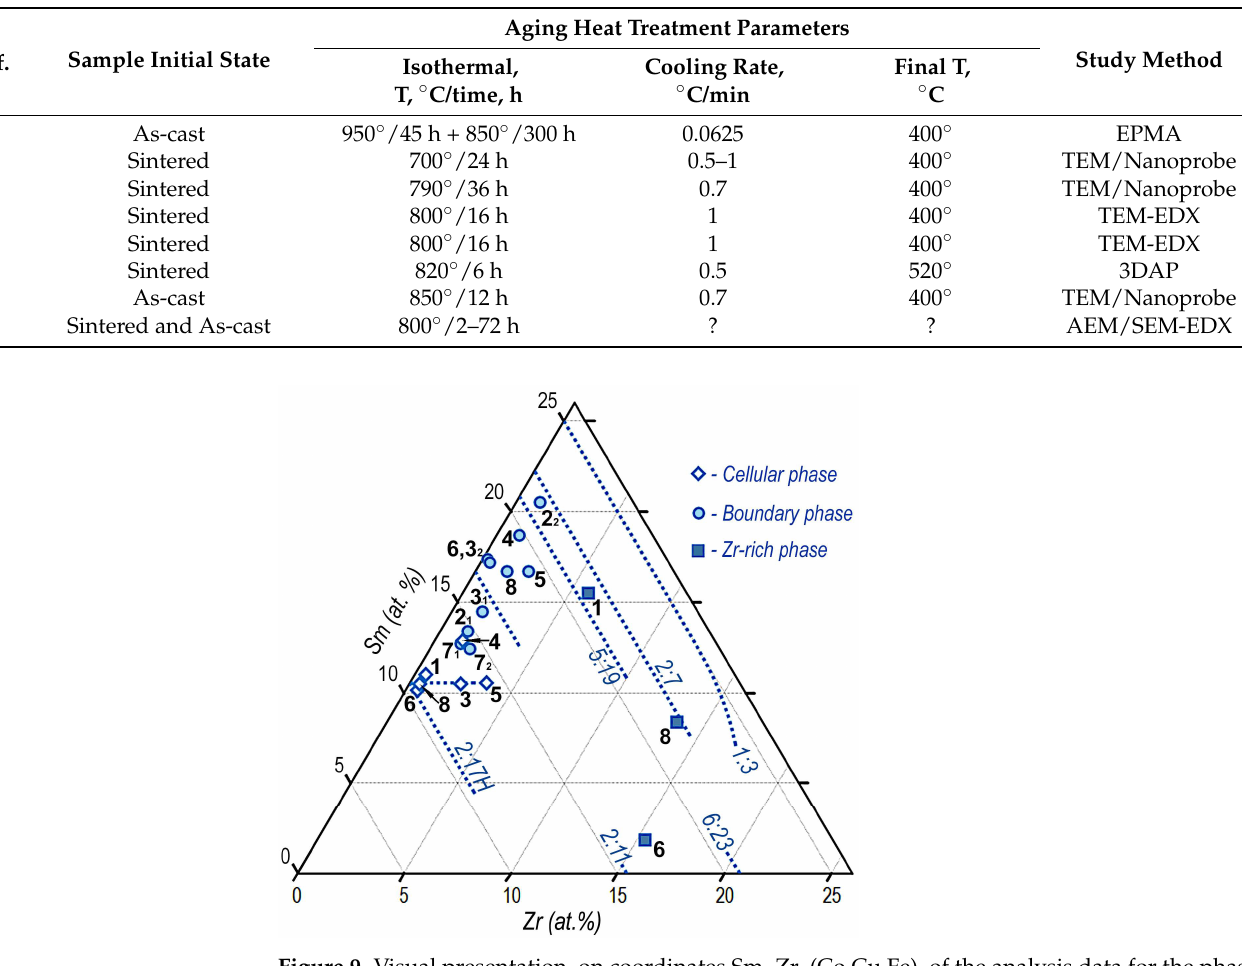
Table 4. Initial states, heat treatment conditions, and experimental methods used for the study of alloys listed in Table 3.